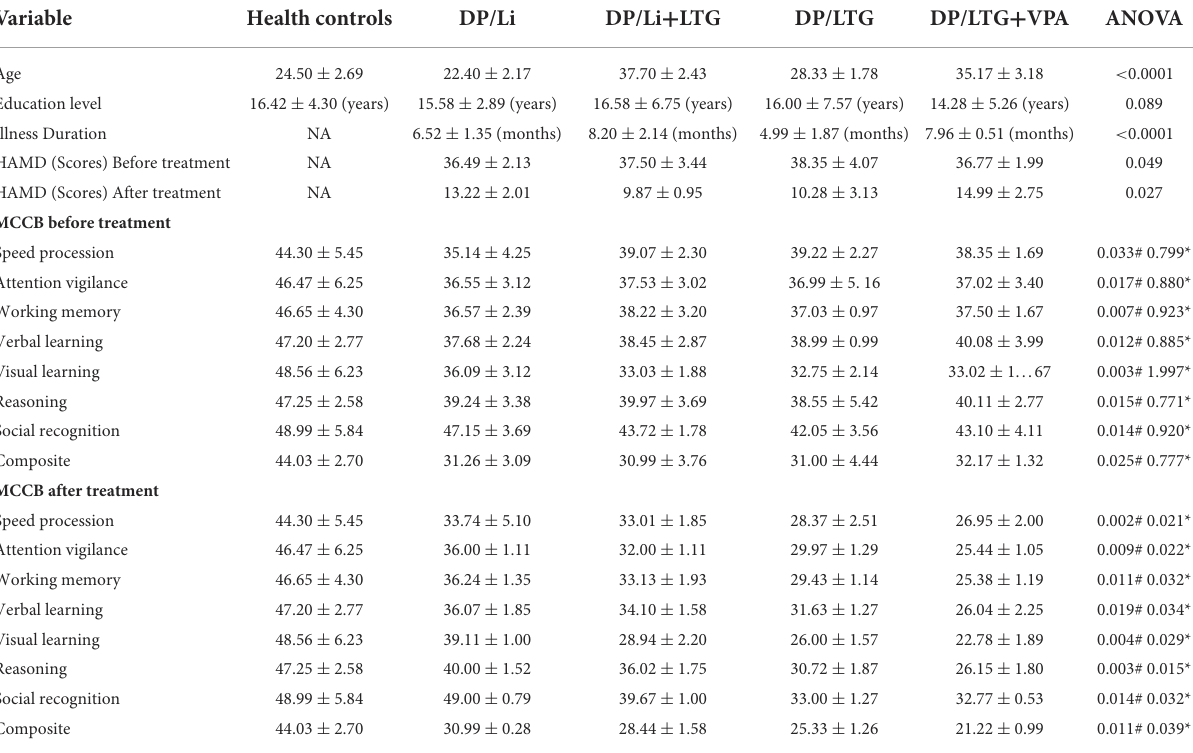
TABLE 1 Sociodemographic and clinical characteristics of patients with BP and healthy controls. Drug-naïve BP patients in the first episode of depression which had a hypo-manic episode